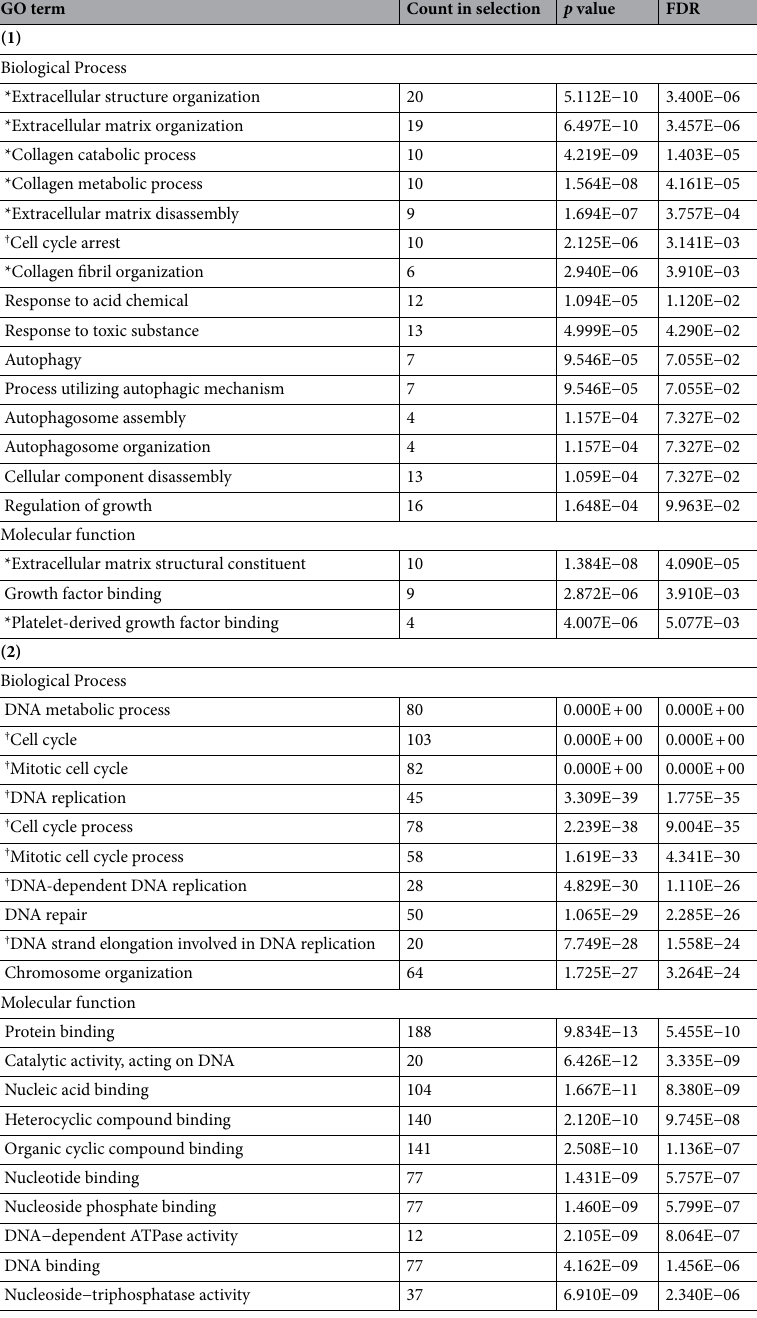
Table 3. 1 Over-represented Gene Ontology Classes, 2 Under-represented Gene Ontology Classes. *Related to myofibroblast differentiation. † Related to cell